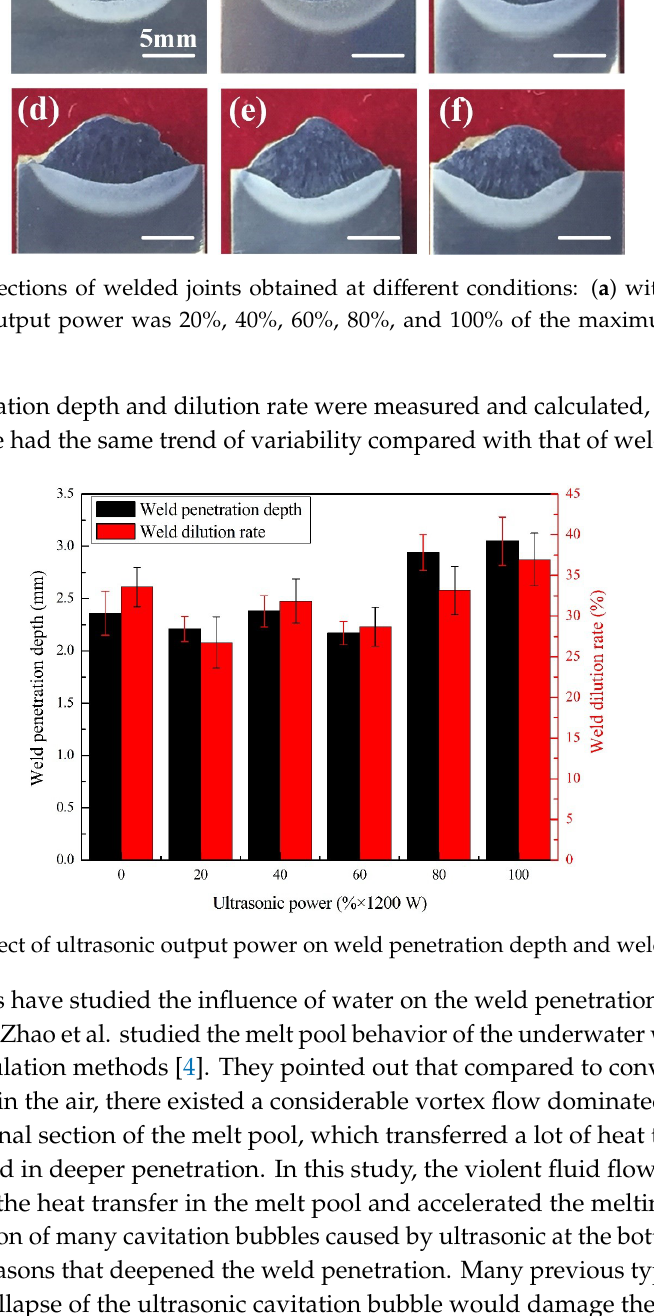
Figure 5. Weld appearances before and after the deslagging at different conditions: ( a ) without ultrasonic; ( b – f ) ultrasonic output power were 20%, 40%, 60%, 80%, and 100% of the maximum power (1200 W), respectively.